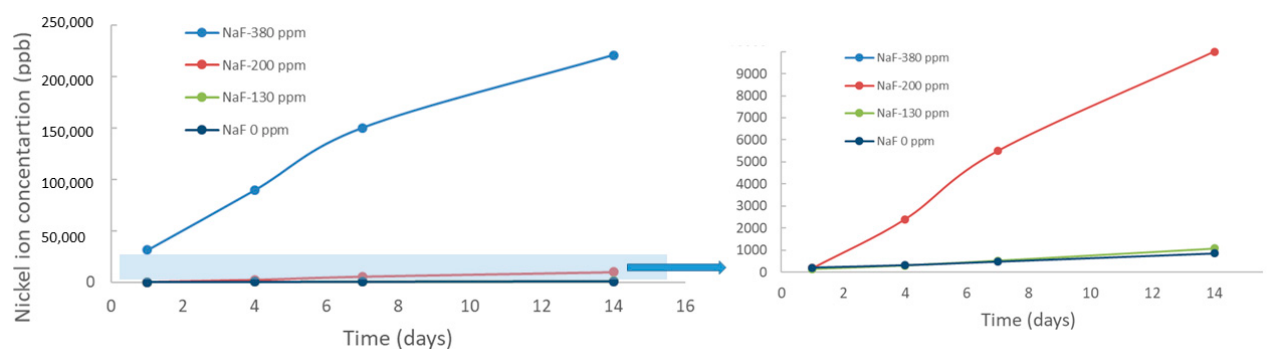
Figure 1. Ni ion release in ppb at different immersion times for each mouthwash studied. The shaded area is enlarged for the 0, 130 and 200 ppm NaF concentrations.